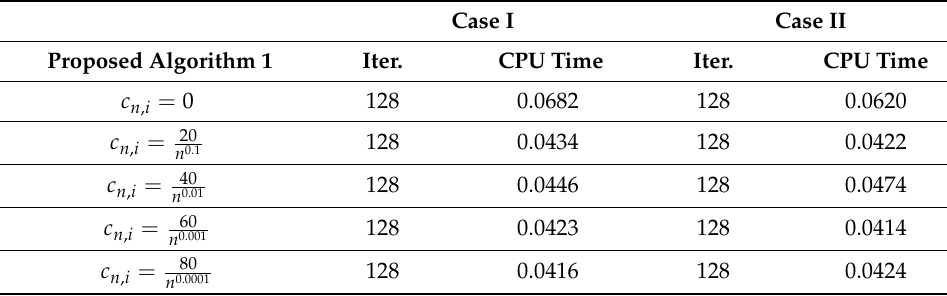
Figure 7. Experiment 3: Case 1. Table 3. Numerical results for Experiment